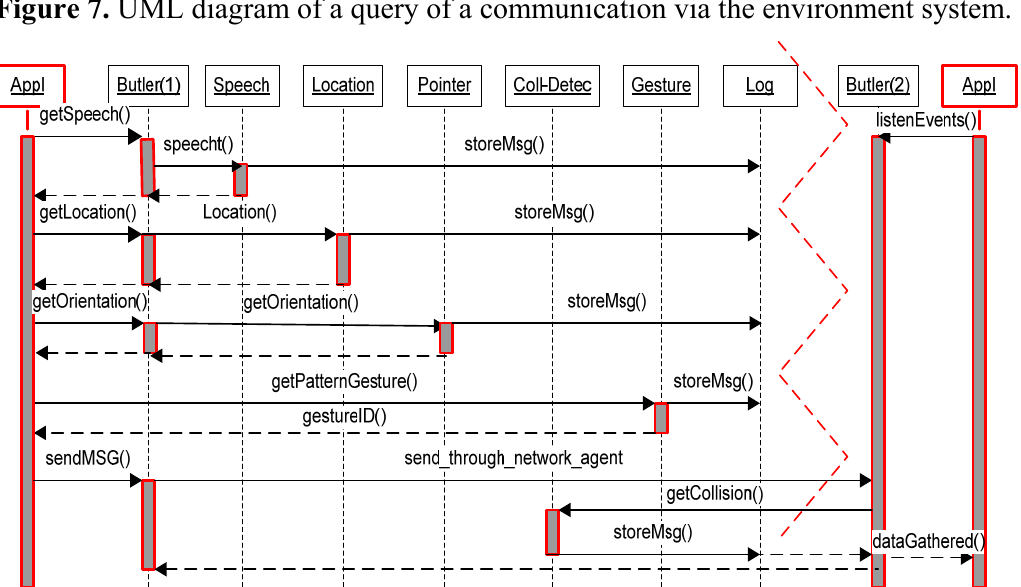
Figure 7. UML diagram of a query of a communication via the environment system.